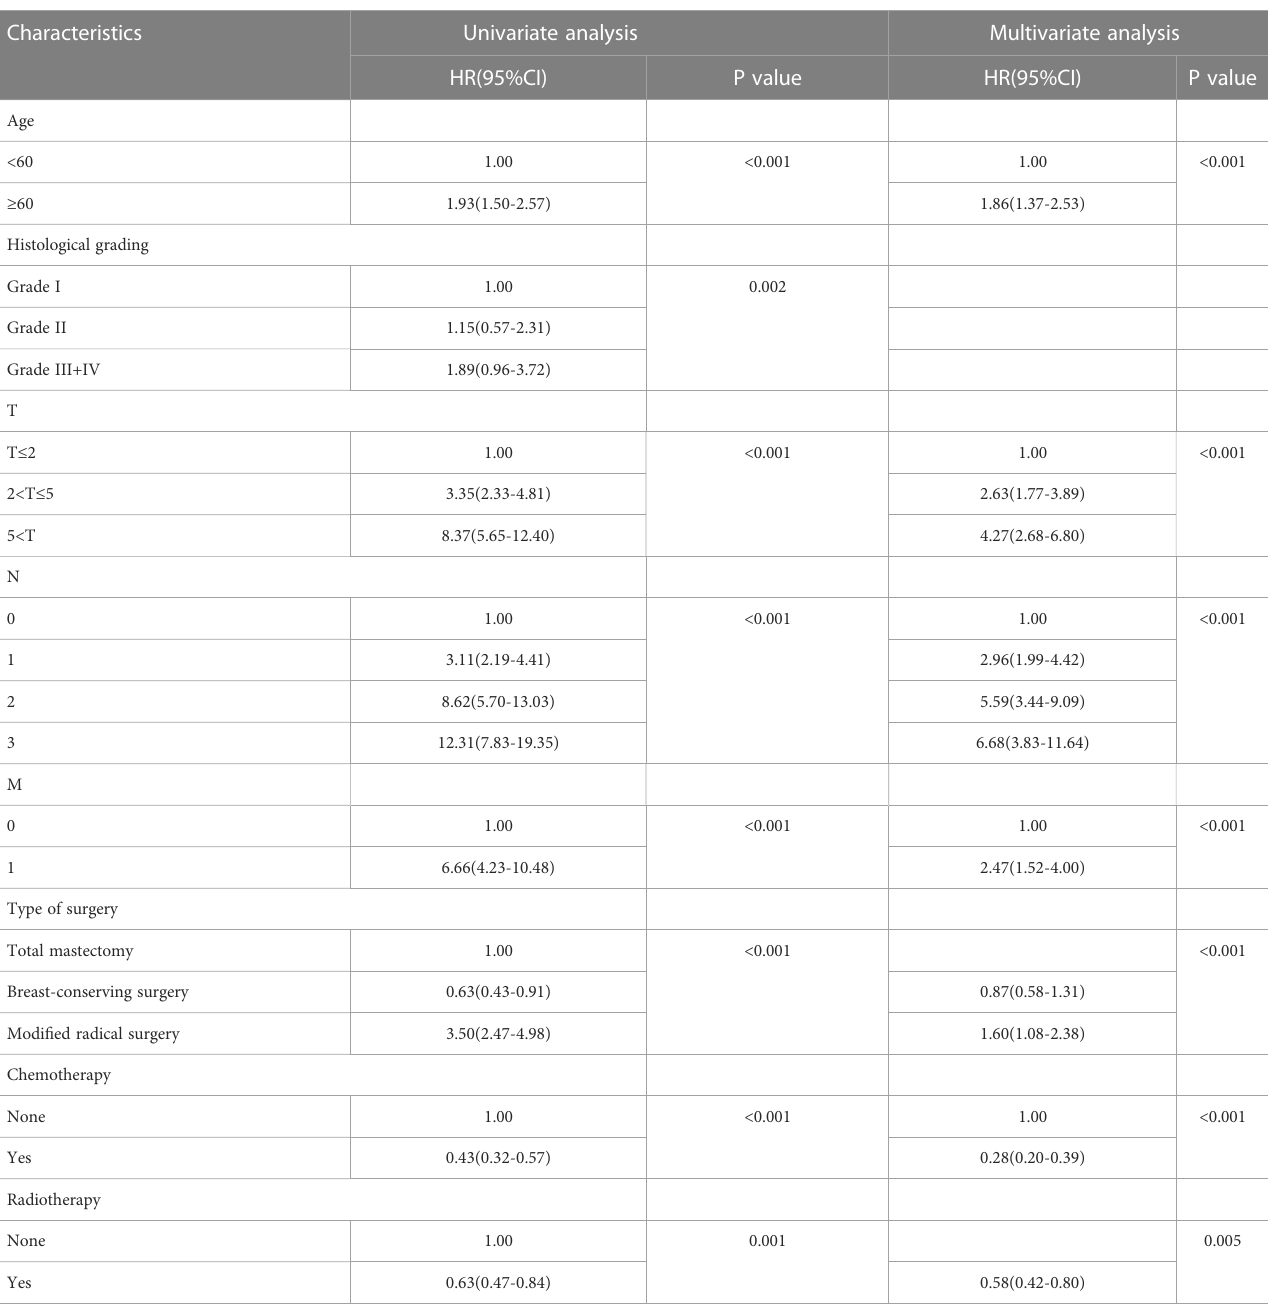
TABLE 2 Univariate and multivariate analysis of TPBC